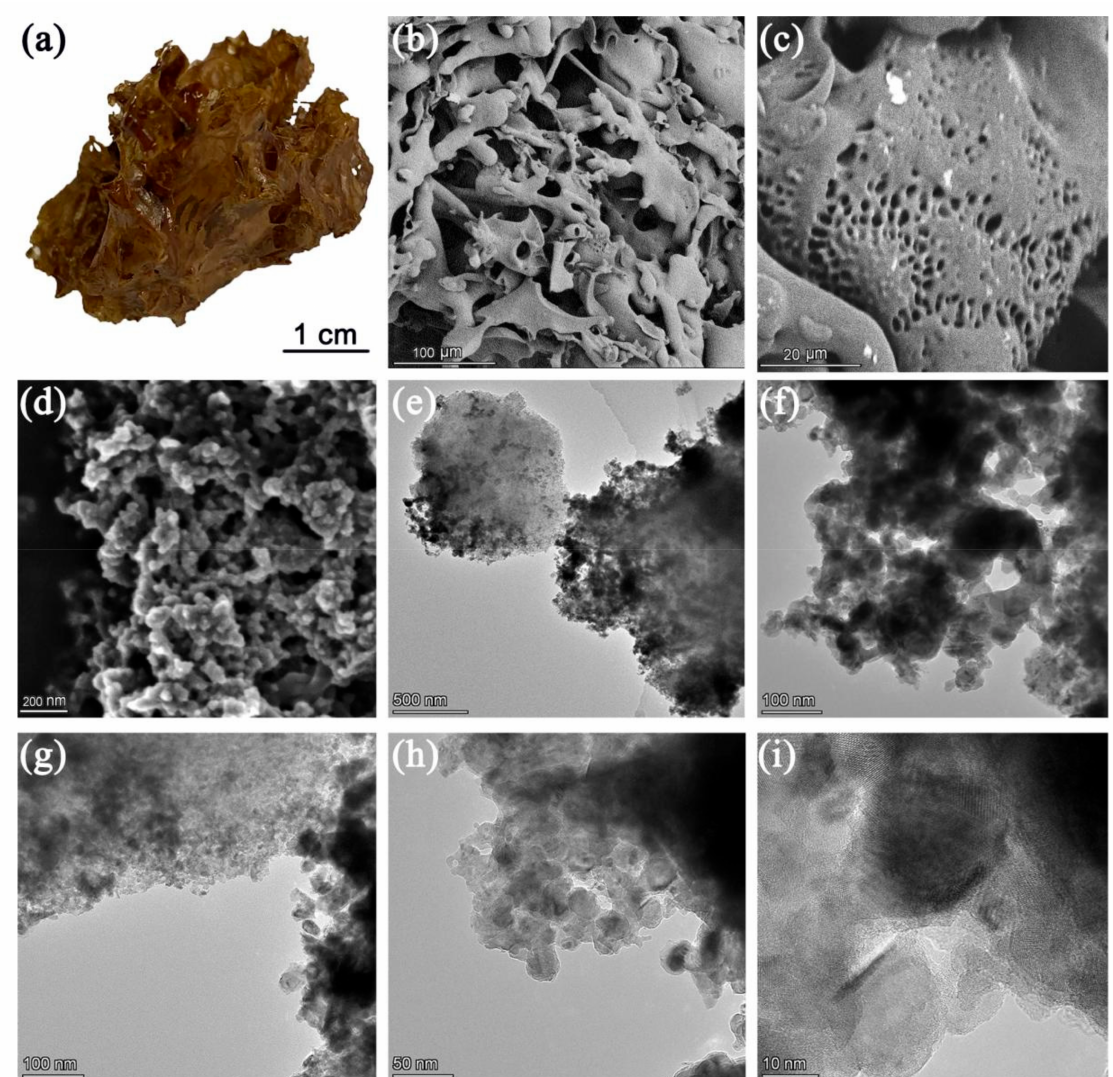
Figure 1. ( a ) The photographs of CNDs aerogel, ( b – d ) the SEM images of CNDs aerogel, and ( e – i ) the TEM images of CNDs